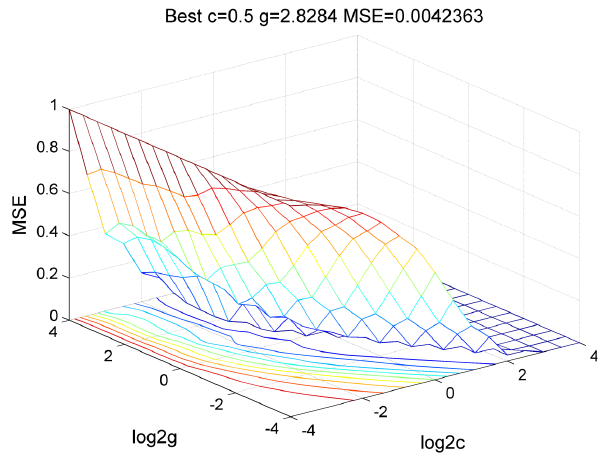
Fig. 8. The fitness curve of searching for the optimal parameters of the multi-factor SVM by GA.